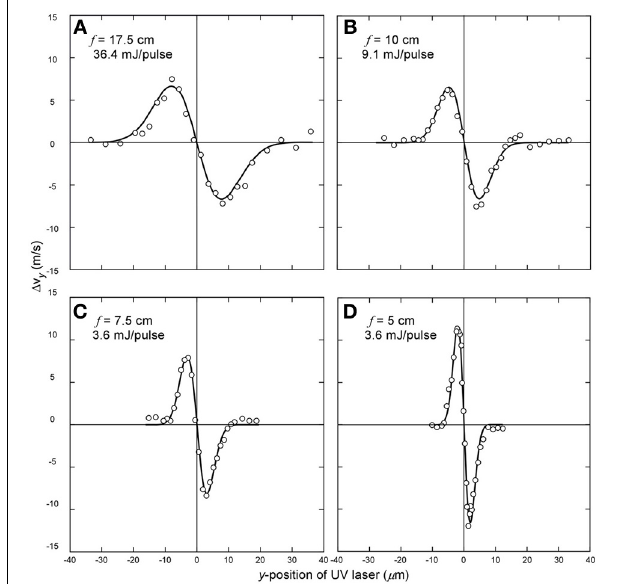
FIGURE 2 | Deflection curves of the transverse velocity change along the y -axis vs. the relative y -position. (A) Focusing the IR laser with a 17.5cm focal length lens for 36.4mJ/pulse, I 0 = 0 . 65 × 10 12 W/cm 2 . (B) Focusing the IR laser with a 10.0cm focal length mirror for 9.1mJ/pulse. I 0 = 0 . 47 × 10 12 W/cm 2 . (C) Focusing the IR laser with a 7.5cm focal length mirror for 3.6mJ/pulse. I 0 = 0 . 43 × 10 12 W/cm 2 .